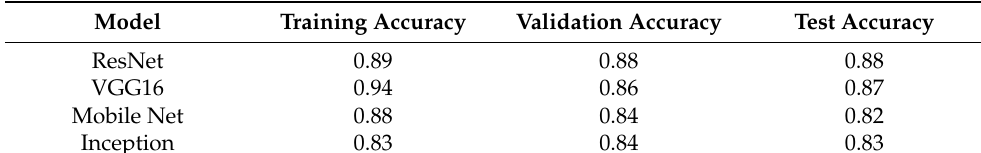
Table 3. Deep learning image classification models performance.